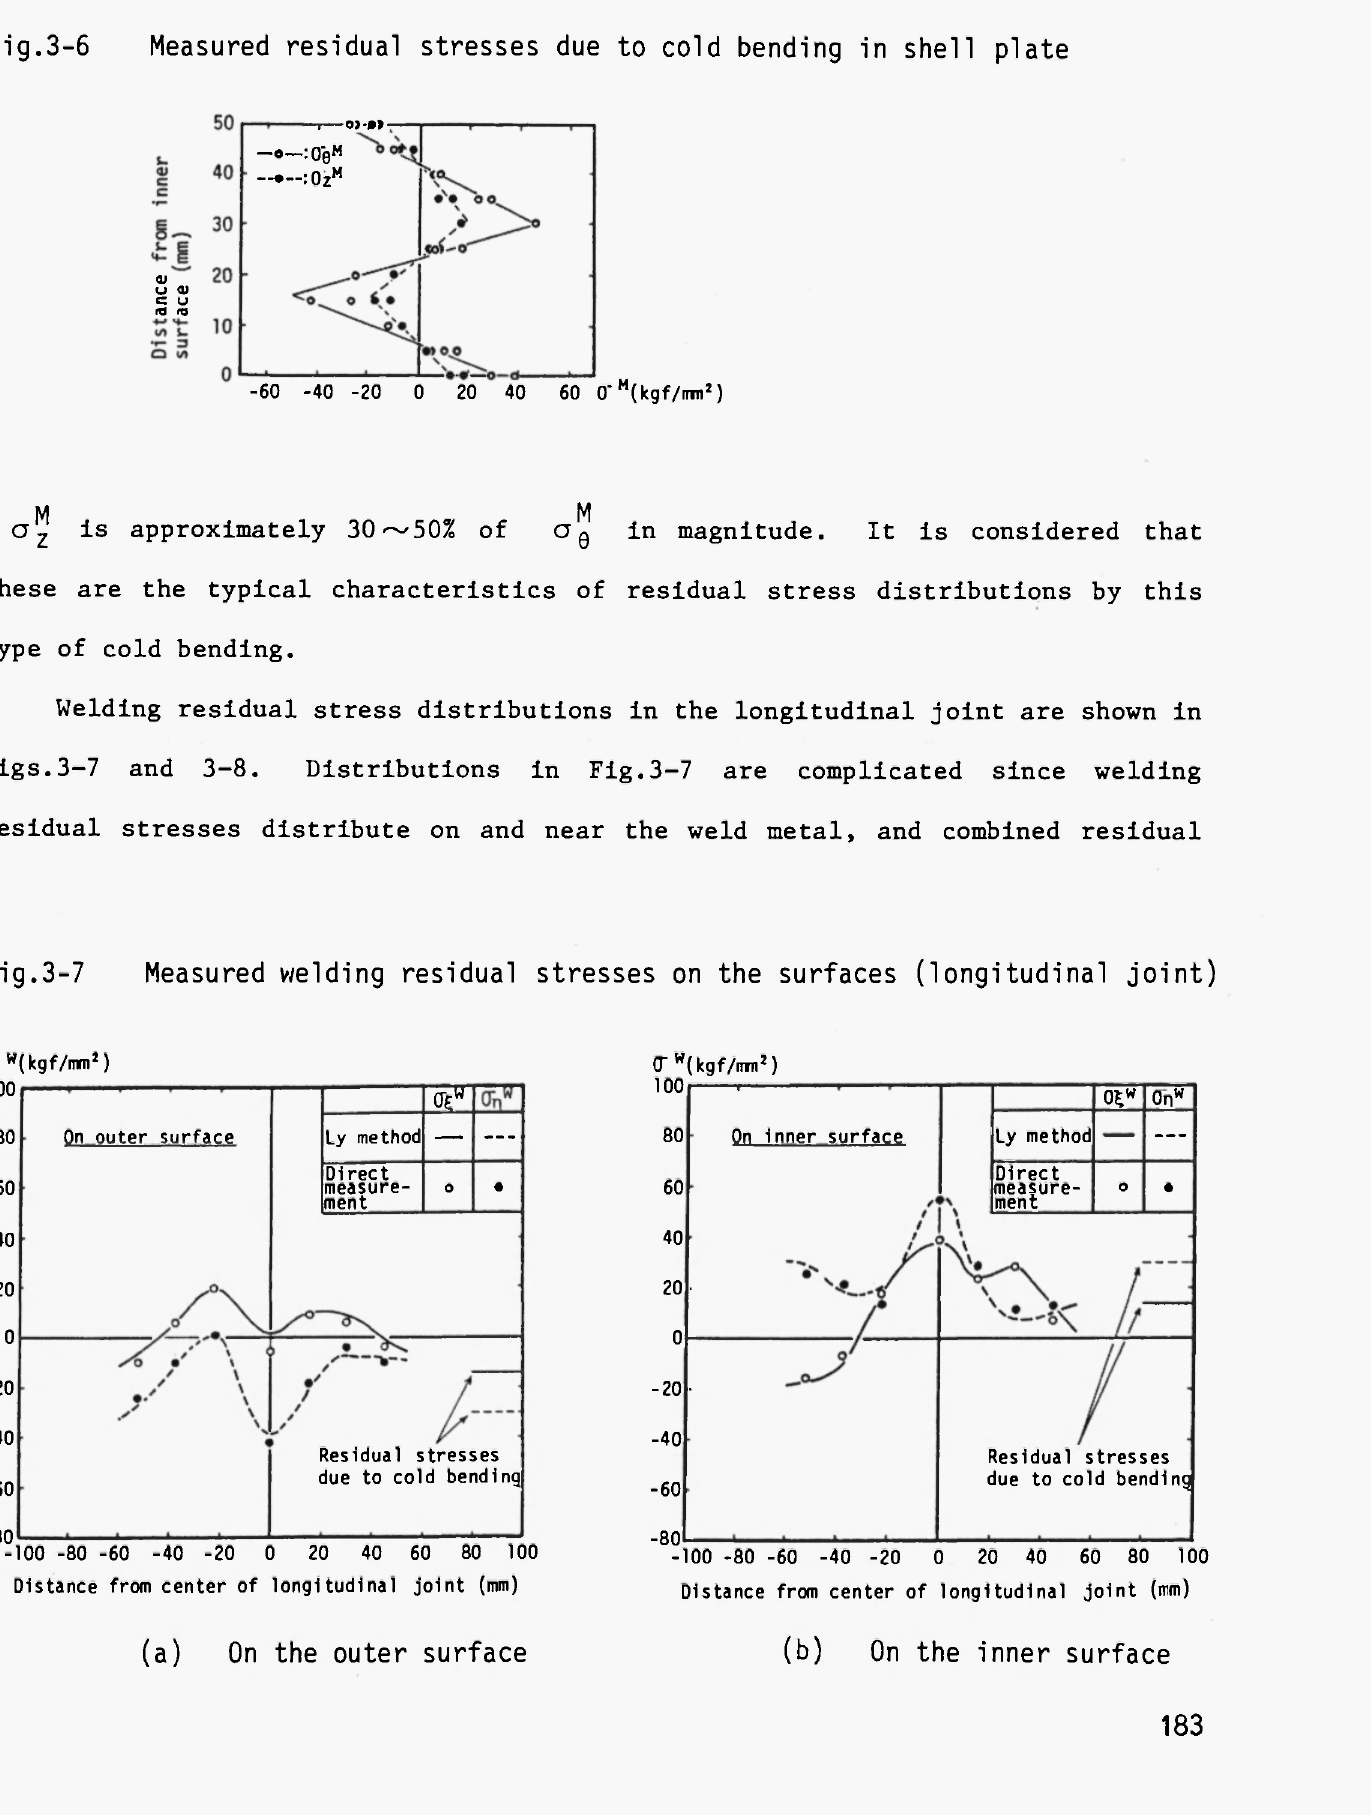
Fig.3-6 Measured residual stresses due to cold bending in shell plate